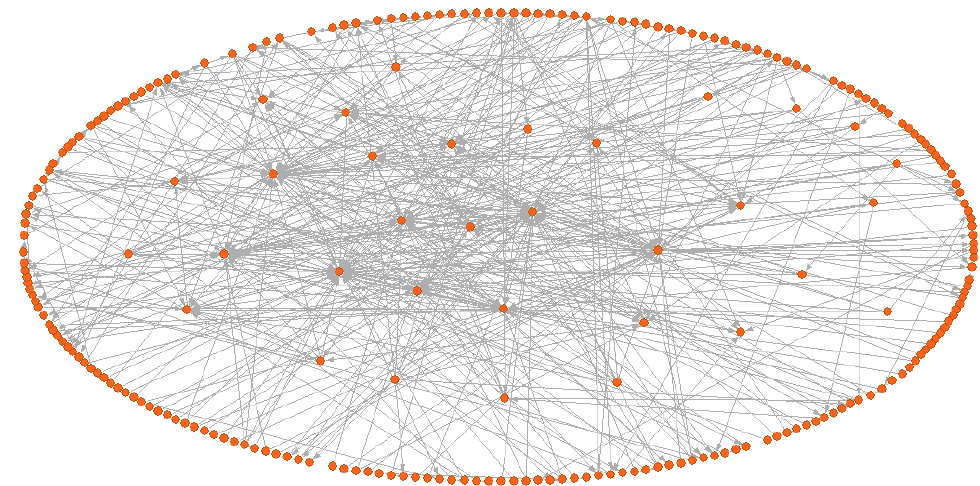
Figure 3. The overall topology of HMTACN.